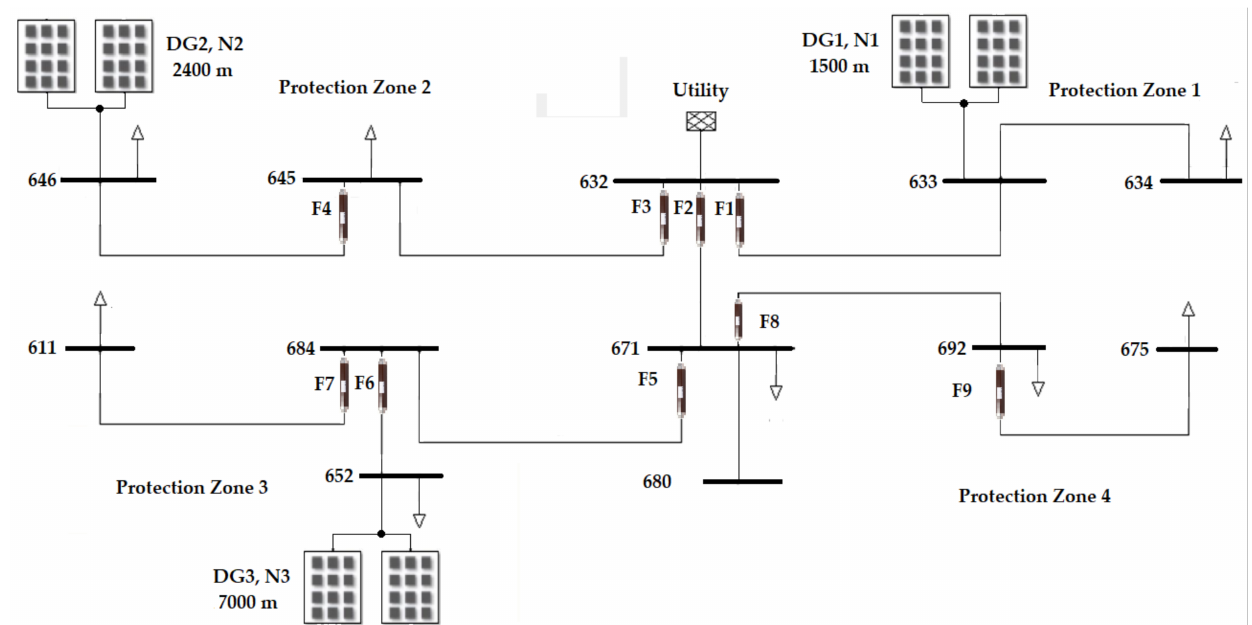
Figure 6. IEEE 13-bus test feeder system used to analyze the performance of the fuses in relation to the